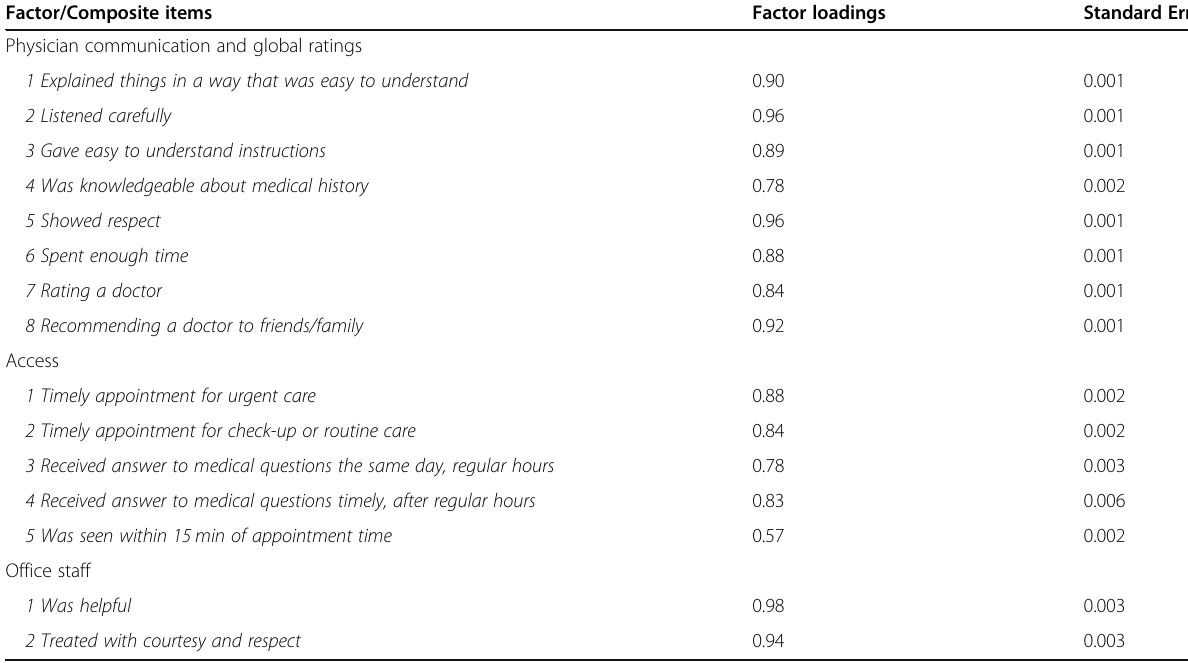
Table 4 Standardized factor loadings and standard errors for CAHPS clinician and group adult visit survey 1.0